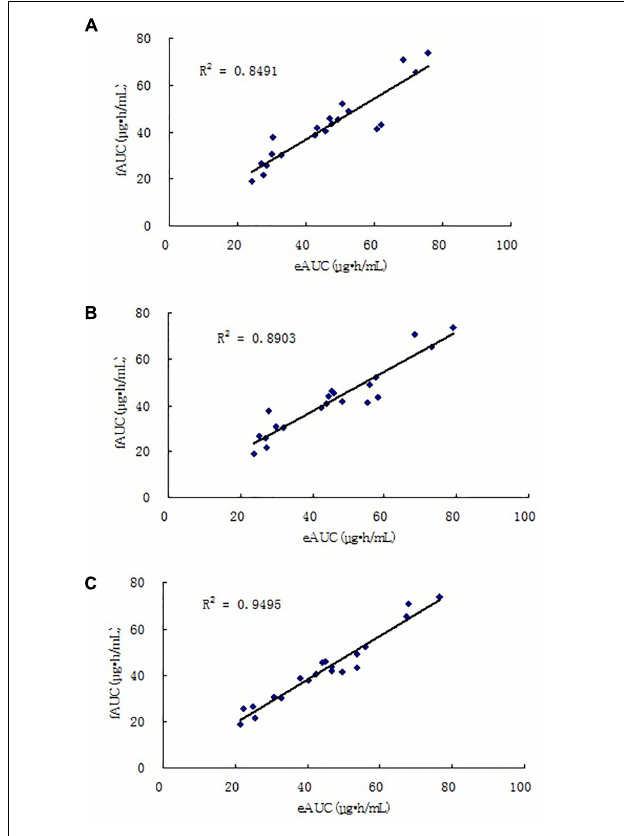
FIGURE 4 | Correlations between eAUC and fAUC calculated using model 2 (A) , model 3 (B) , and model 4 (C) .